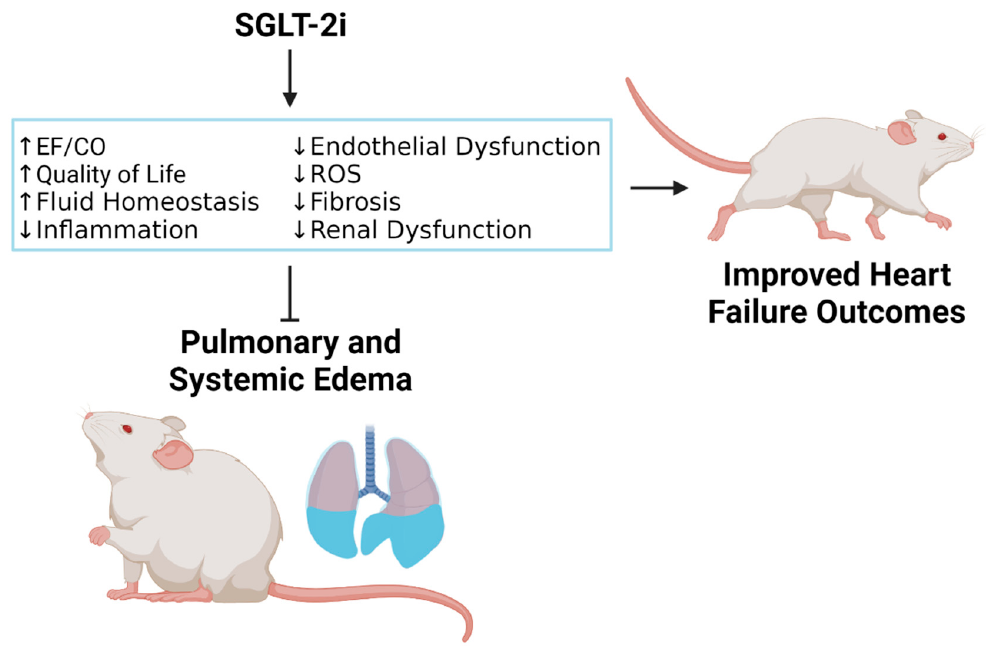
Figure 1. Mechanism by which sodium–glucose cotransporter 2 inhibitors (SGLT-2i) reduce pulmonary and systemic edema in HFrEF. Ejection fraction (EF); cardiac output (CO); reactive oxygen species (ROS). Created with BioRender.com on 18 July 2022.